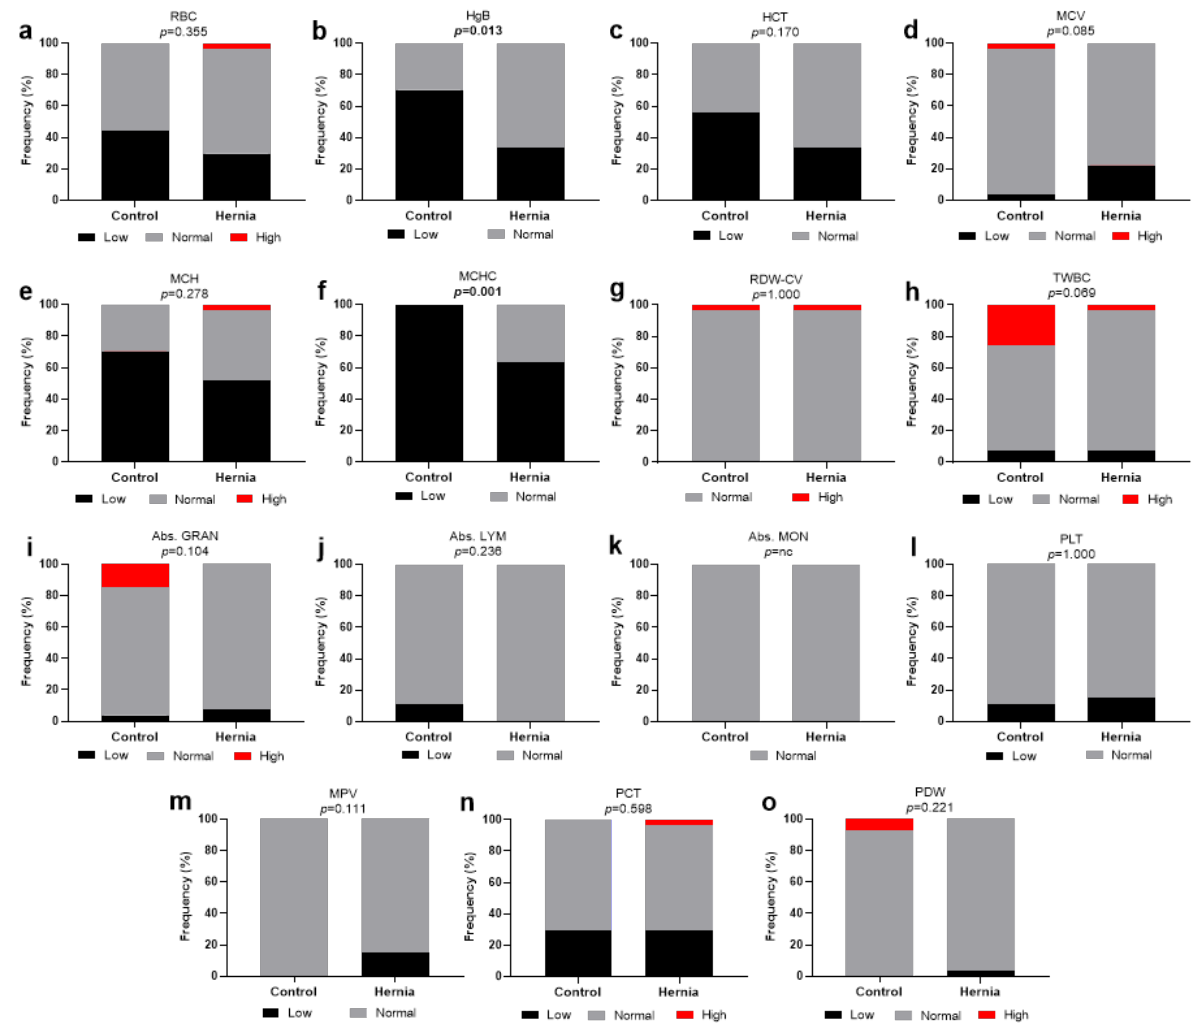
Figure 4. Frequency of derangements in blood cell indices among the study subjects at Mankranso District Hospital, Ghana stratified by control and hernia groups. Pearson Chi-Square and Fisher’s Exact tests were used appropriately to compare the difference in proportions between control and hernia groups; (a) RBC: Red blood cell, 4.50-6.50 ×10 6 /µL; (b) HgB: